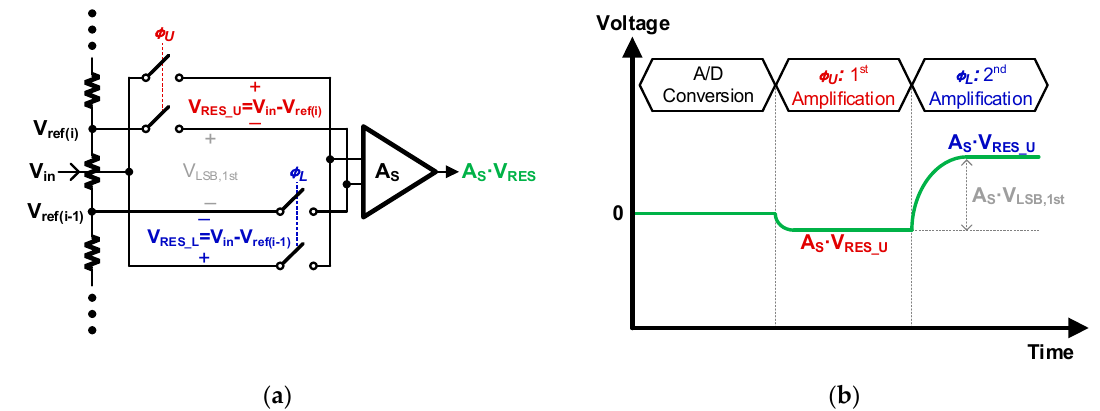
Figure 5. Conceptual operations from Flash ADC: ( a ) Block diagram; ( b ) Timing diagram.